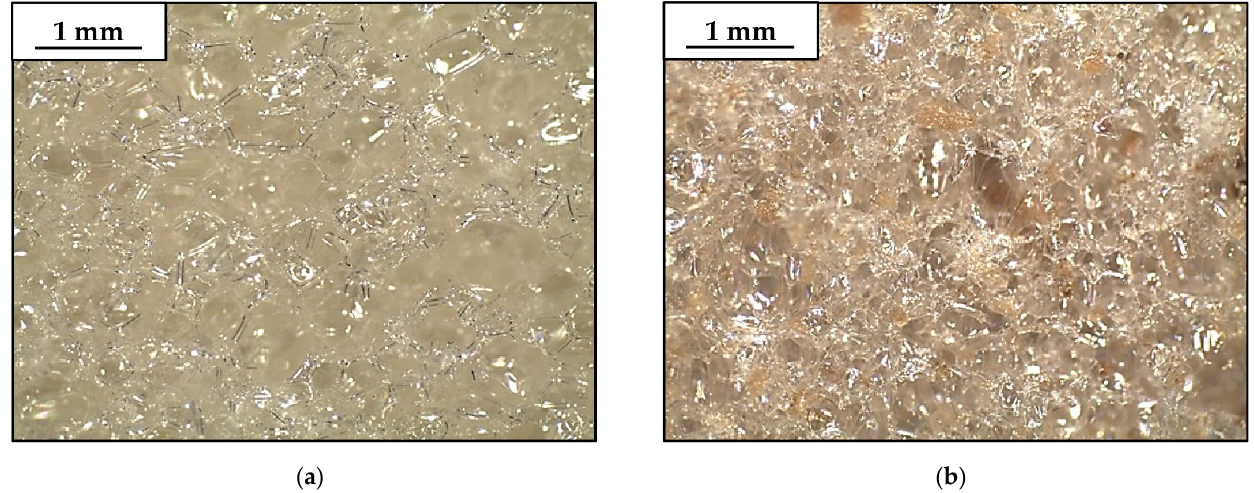
Figure 8. Optical microscopy of polyurethane samples at 20× magnification with 0 wt% ( a ) and 15 wt% ( b ) of cork waste.